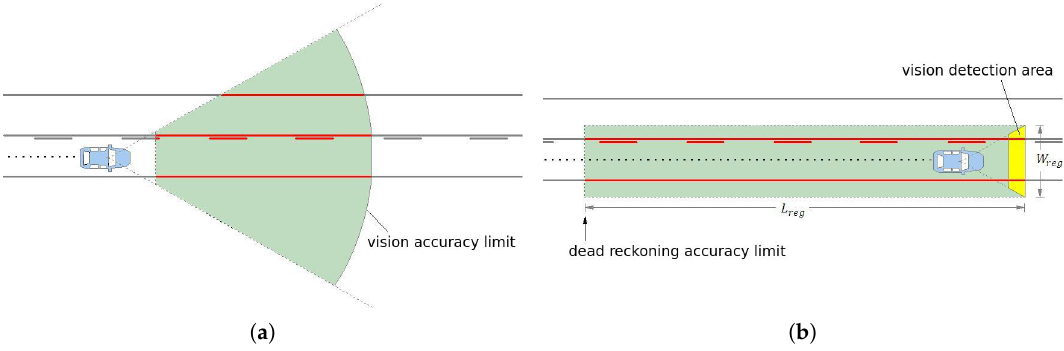
Figure 1. ( a ) Typical medium-range detection limited by the visual accuracy; ( b ) our approach based on short-range detection (yellow) and dead reckoning.